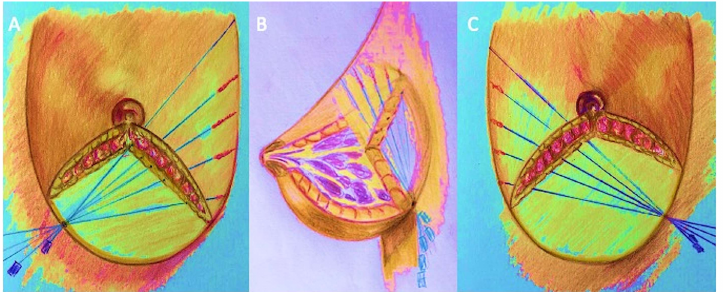
Figure 3. Painting of the “Gentle technique” for autologous fat injection. ( A ) Access point in lower- external quadrant located at 247.5 ◦ of the breast. ( B ) 3D painting of fat injection into the breast through three inframammary fold access located at 135 ◦ , 180 ◦ , 225 ◦ . The autologous fat injection was always performed in the infra and sub-glandular plane—not in the muscle. ( C ) Access point in lower-internal quadrant located at 112.5 ◦ of the